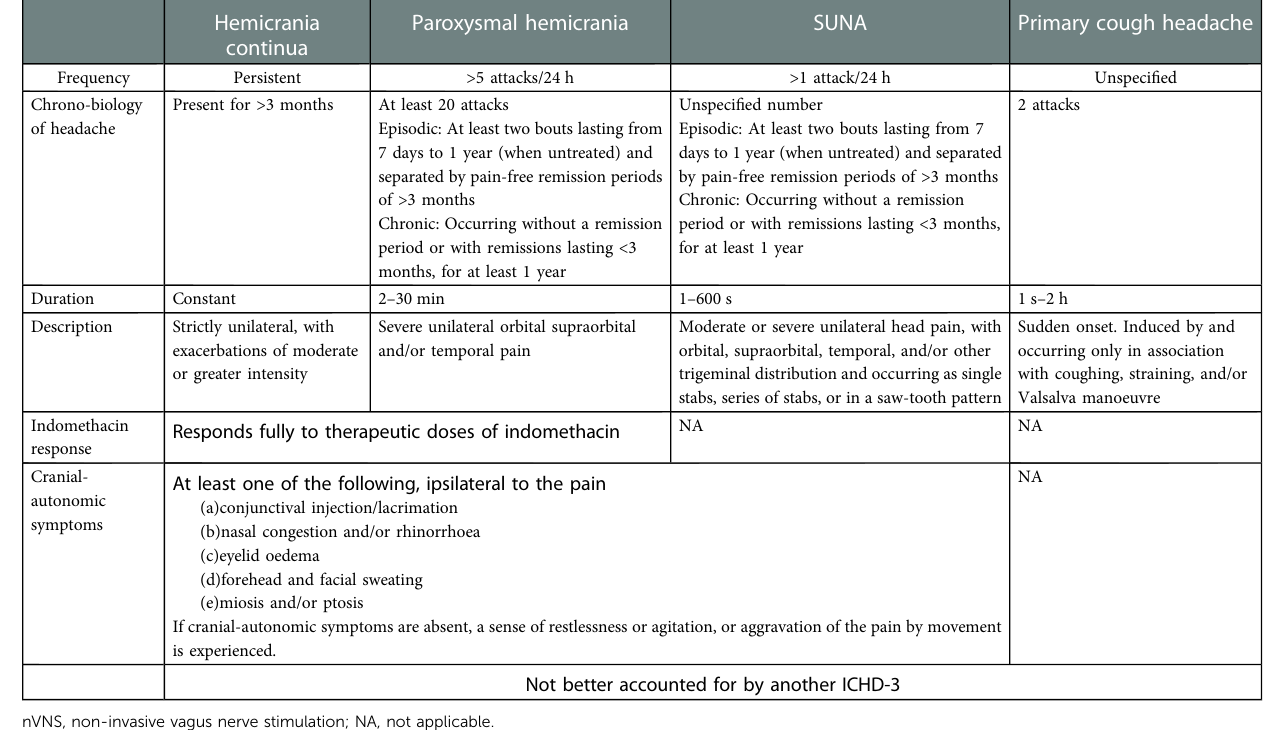
TABLE 1 Main features of the primary headaches treated with nVNS, modi fi ed from the ICHD-3, International Classi fi cation of Headache Disorders, 3rd edition.